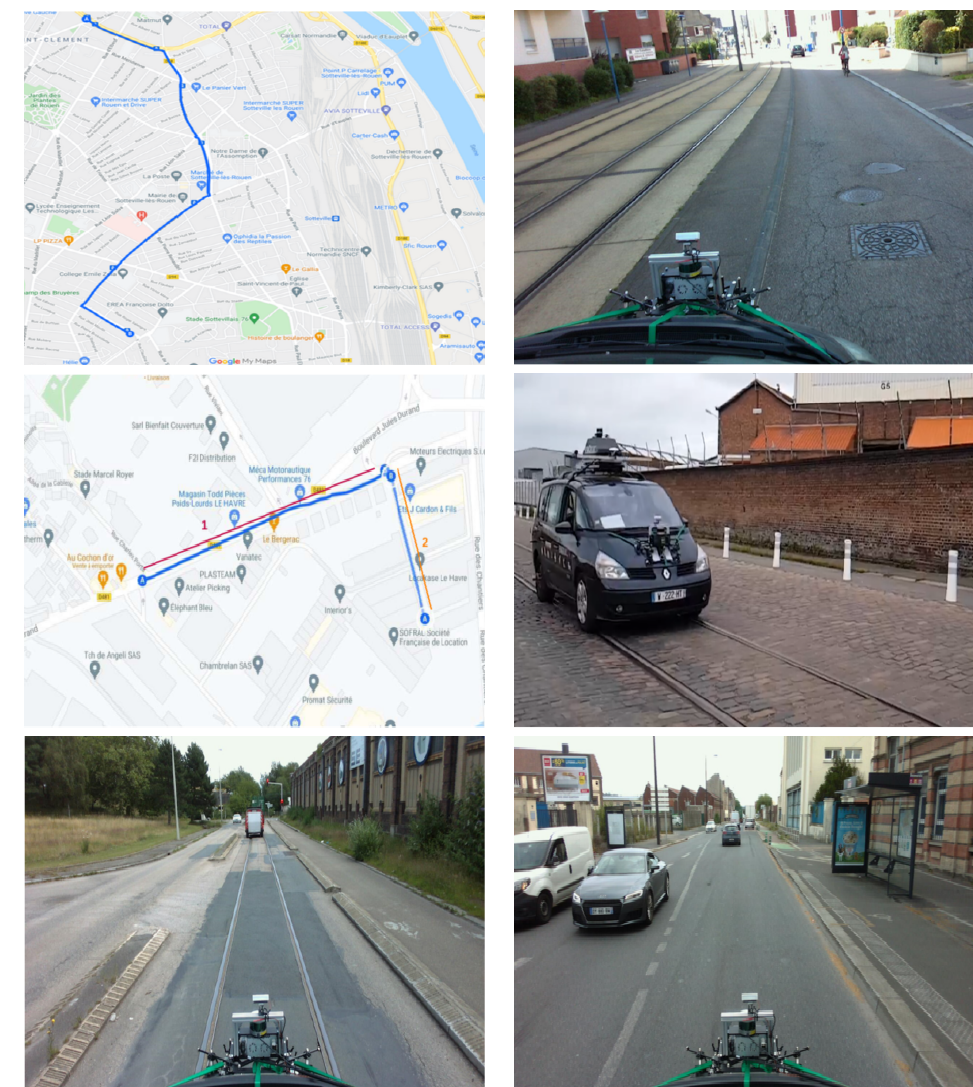
Figure 10. Data collection on both road and railway environment. Top level left : route Google Maps Rouen, top level right : data collection in Rouen city center, middle level left : route Google Maps Le Havre, middle level right : data collection in Le Havre city center, bottom level left : data collection from railway point of view in Le Havre, and bottom level right : data collection from road point of view in Le Havre